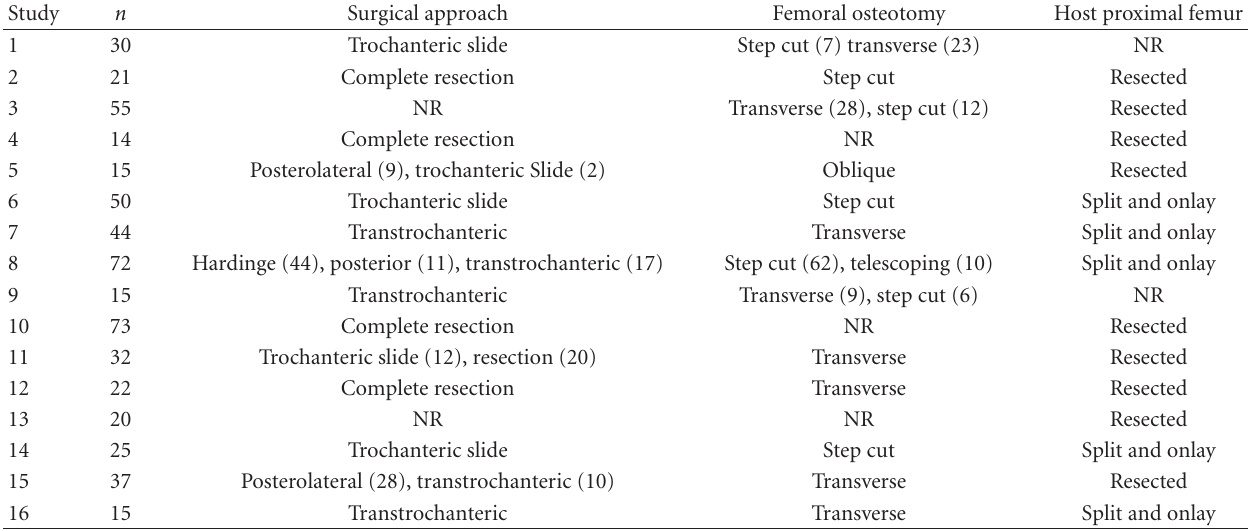
Table 2: Surgical techniques used including approach, the type of femoral osteotomy performed at the host bone-allograft junction, and whether the host proximal femur was resected or split and used as an onlay graft. NR: not reported. Study numbers correlate with Table